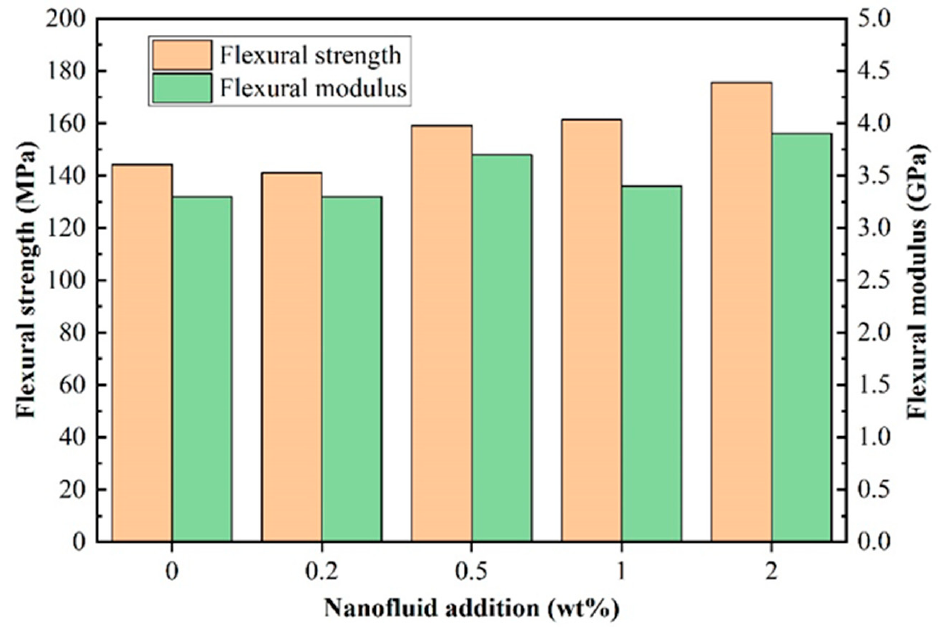
Figure 5. Flexural strength and flexural modulus of BPEI-ZIF-8/IL/EP composites.